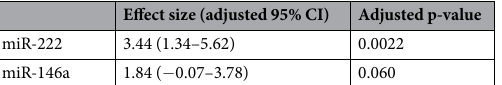
Table 3. The estimated changes in miR-222 and miR-146a associated with screen time, adjusted using Monte Carlo simulation. * Effect sizes represent the mean % change with the 95% confidence intervals in miRNA for a 1-hour increment in weekly screen time. Models were adjusted for gender, age, passive smoking exposure, maternal education and RNA content of the extracellular fraction. Monte Carlo simulation was repeated 10,000